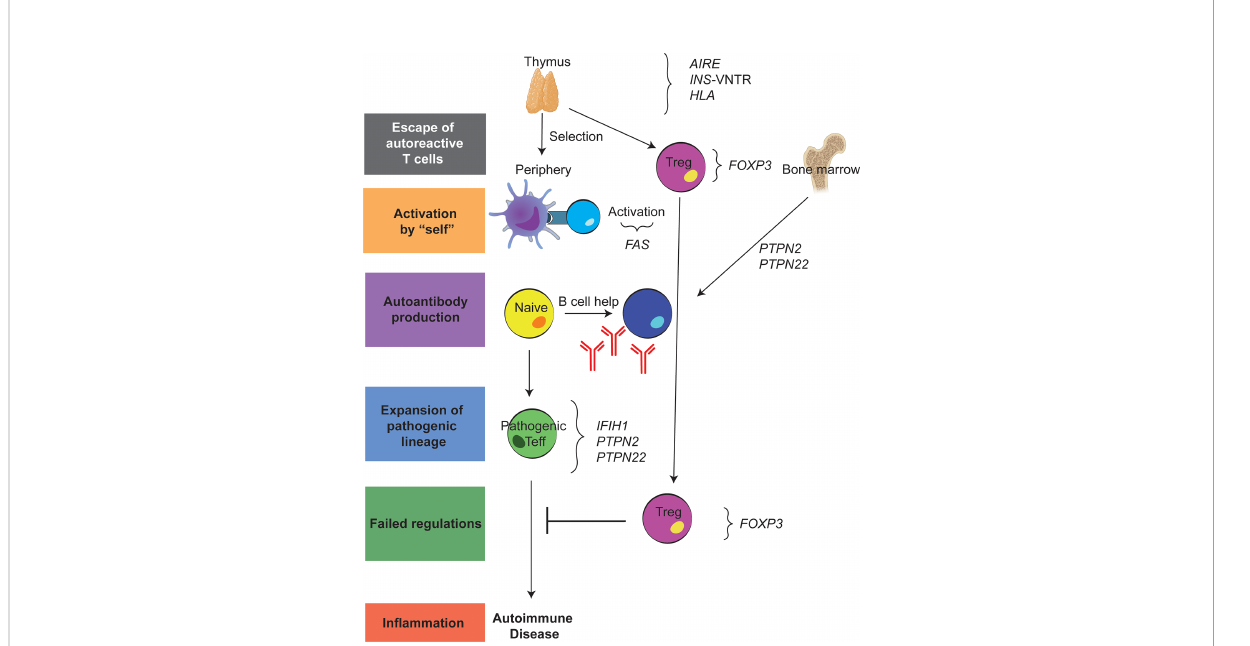
FIGURE 2 Genetic variants underlying failed immune tolerance and development of autoimmunity. Schematic showing where each of the discussed variants contribute to the loss of tolerance both in the thymus and the